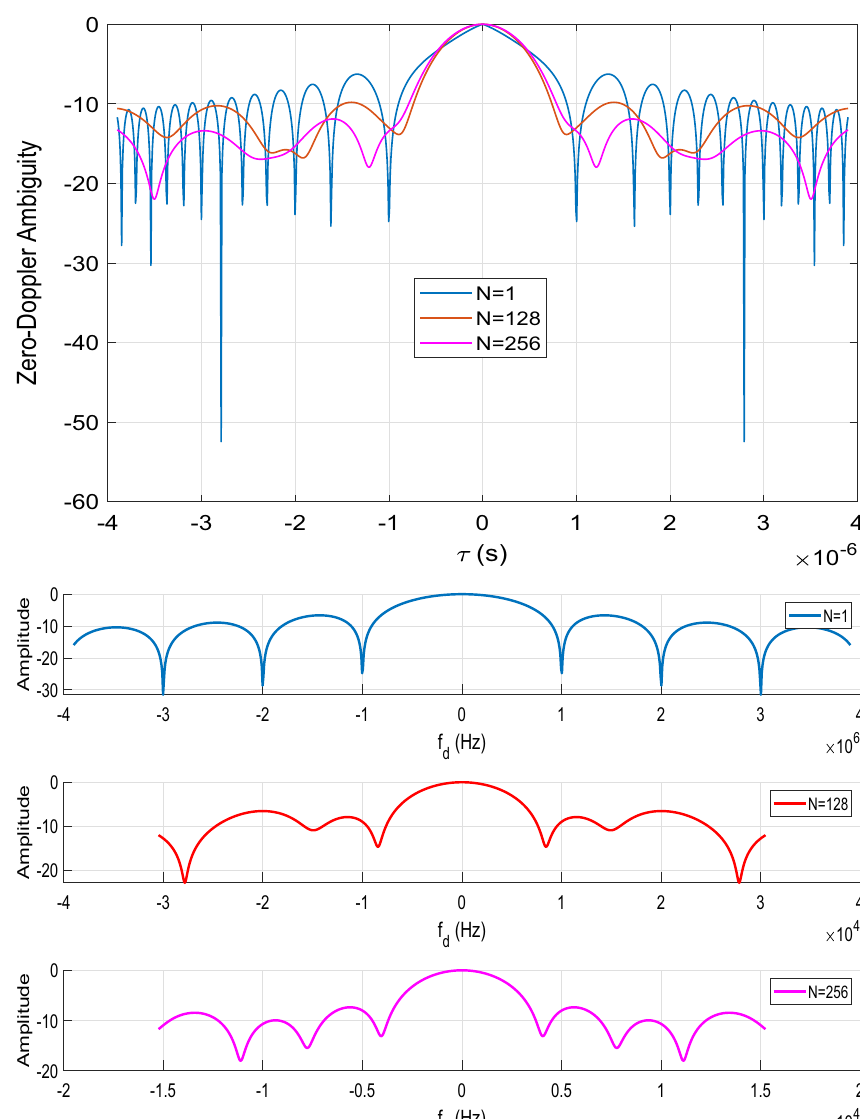
Fig. 8 Amplitude of the OCDM CAF: a-(top)) zero-Doppler cut, b-(bottom)) zero-delay